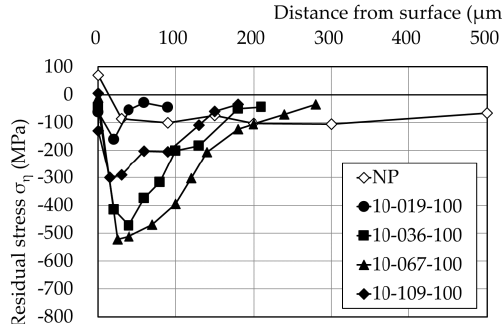
Figure 8. Residual stress depth distribution (10 mJ).